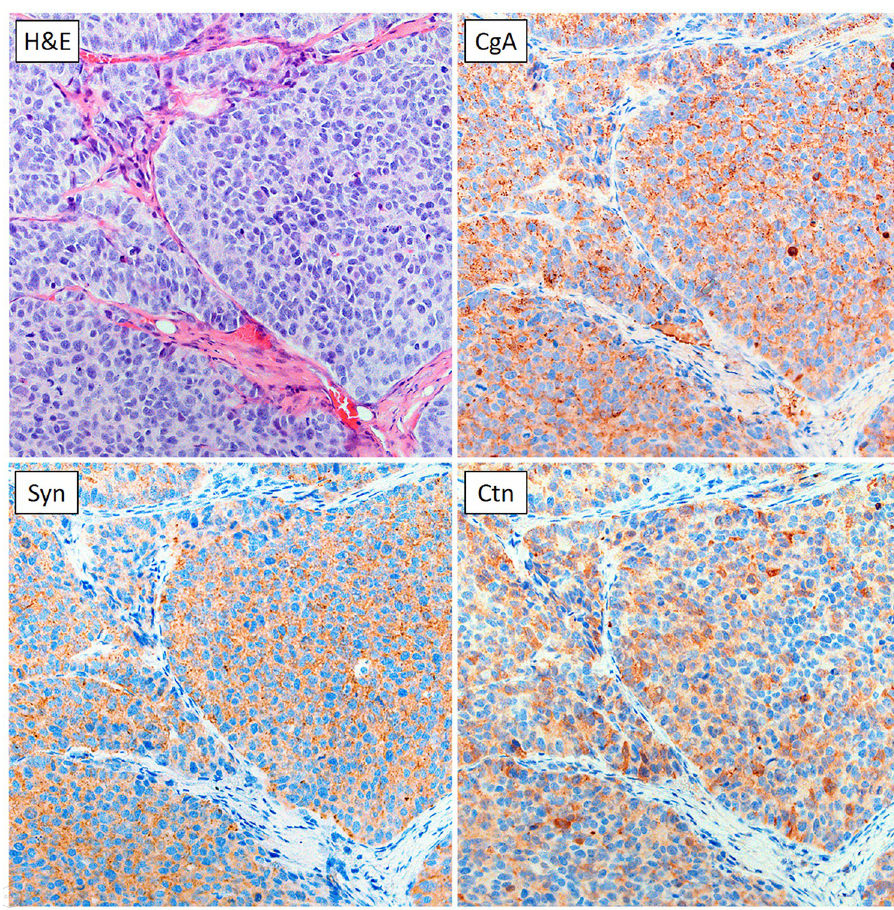
Fig 3. IHC staining of a GOT2 tumour. Tumours from mock-treated animals were harvested at the end of follow-up and stained with haematoxylin and eosin (H&E), and for three markers for MTC: chromogranin A (CgA), synaptophysin (Syn), and calcitonin (Ctn). In this representative example (at 20x magnification), a high and specific expression can be seen for all three